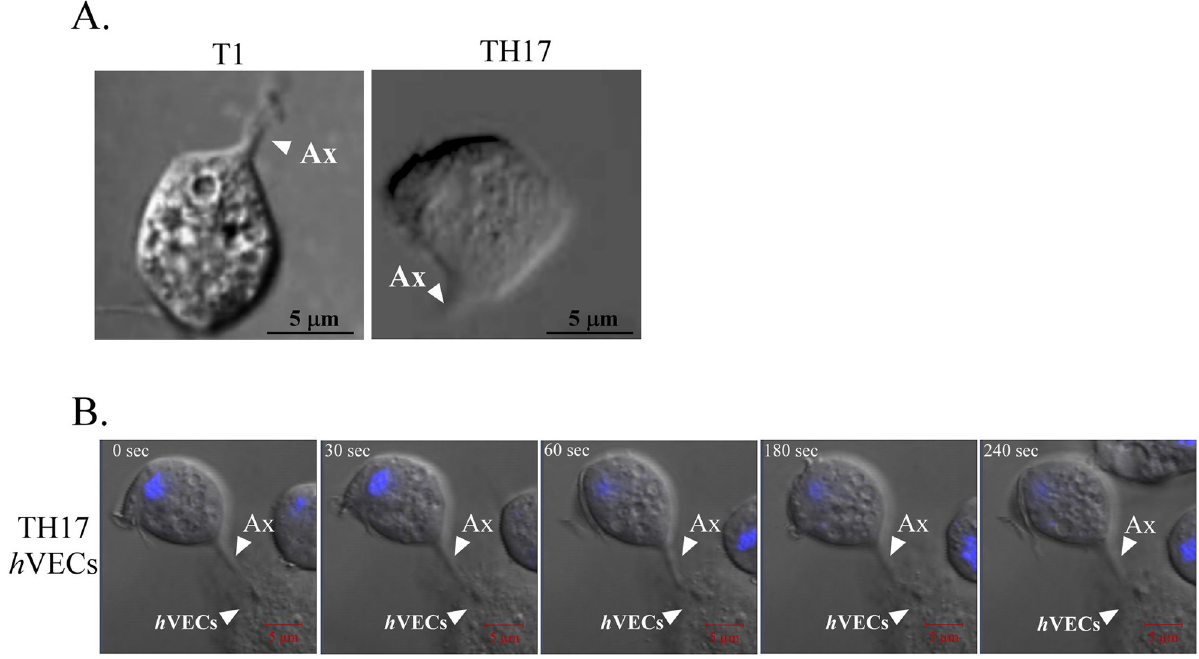
Fig 5. Real-time imaging of the host-parasite interactions. The behavior of T1 or TH17 trophozoites in the presence (A) or absence (B) of h VECs was recorded by real time-imaging (S4, S5 and S6 Videos). A representative touchdown scenario of a T1 or TH17 trophozoite on the glass surface via the axostyle is captured as shown in (A). Anchor of a Hoechst 33342-labeled TH17 trophozoite on a h VECs over 4 min with contiguous bulging and shrinking of its axostyle is shown in (B). Notably, the duration of the anchor varied in the individuals. Real-time images were captured by DIC at the rate of 1 frame per 30 sec over 30 min. White triangles indicate where the parasite axostyle (Ax) or human cells ( h VECs) are located.